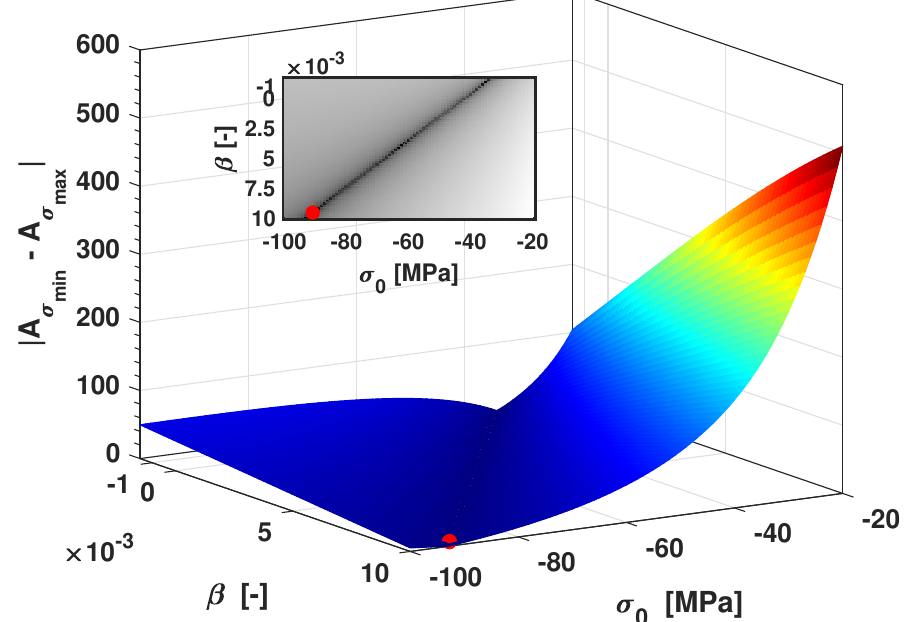
− A σ | surface of Equation (13) with respect to β and σ Figure 7. | A σ max min shows the top-view of the surface with a gray logarithmic color-map scale, while the red dot indicates the